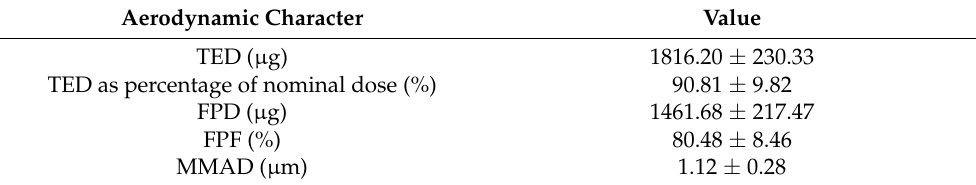
Table 5. Aerodynamic characterization of the optimal NFD-CTS-PLGA nanocomposites. Aerodynamic